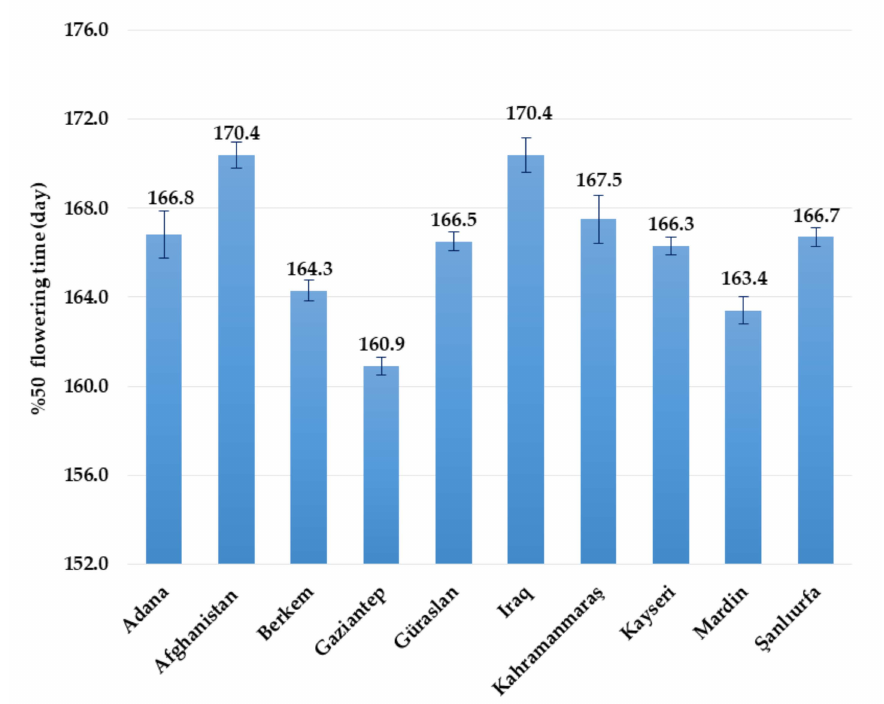
Figure 4. Average 50% flowering times for fenugreek genotypes.